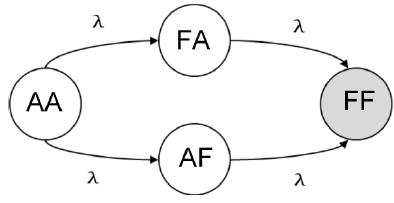
Fig. 5. CTMC of SM/DS subsystem.